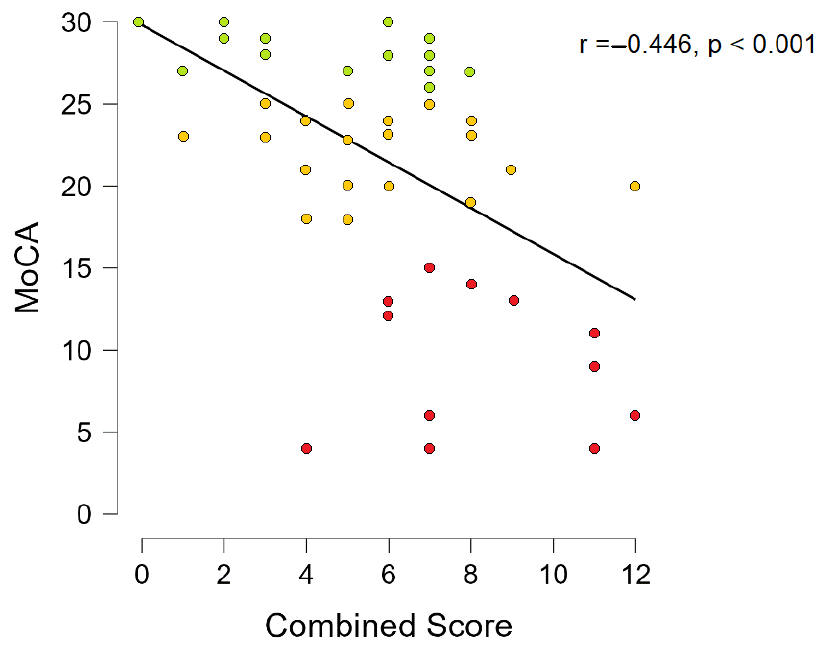
Figure 10. MoCA and combined score scatter plot with a trendline (red dots, participants in dementia group; yellow dots, participants in MCI group; green dots, participants in normal cognition group).